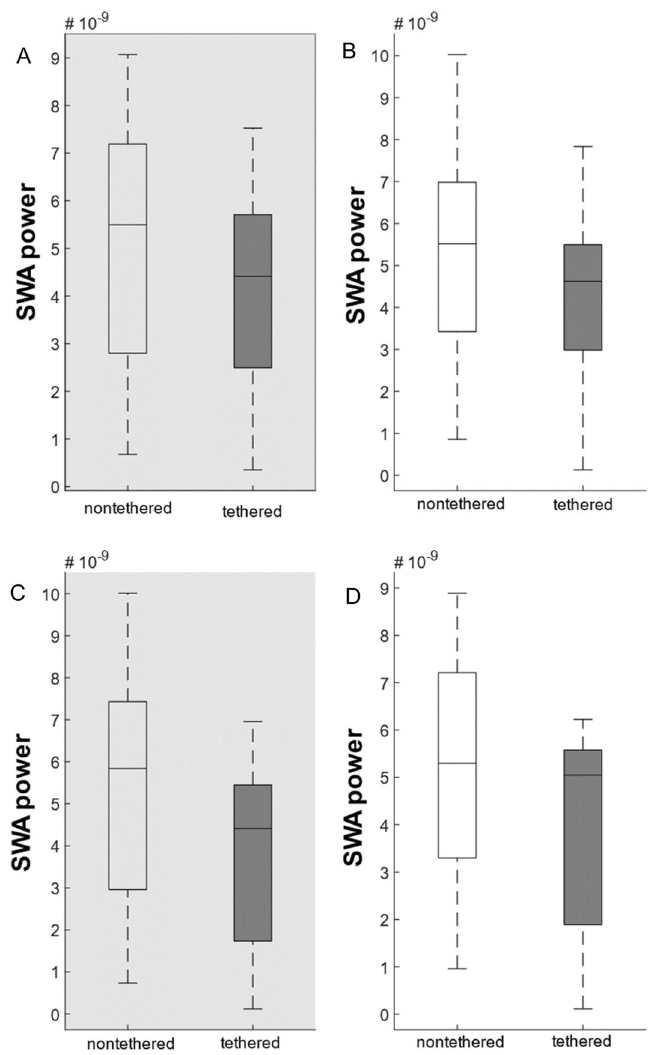
Figure 6. SWA power of the nontethered (n = 6) and tethered (n = 7) animals for each 10-s episode that was scored NREM. ( A , B ) Averaged values for the first 3 days of the experimental observation period (early) for the dark phase ( A ) and light phase ( B ). There was no significant difference between the nontethered and tethered animals in the dark phase ( A ) and in the light phase ( B ). ( C , D ) Averaged values for the last 3 days of the experimental observation period (late) for the dark phase ( C ) and light phase ( D ). There was no significant difference between the nontethered and tethered animals in the dark phase ( C ) and in the light phase ( D ). Box- plots show minimum to maximum values with median. Differences between the groups were tested using the Mann–Whitney-U